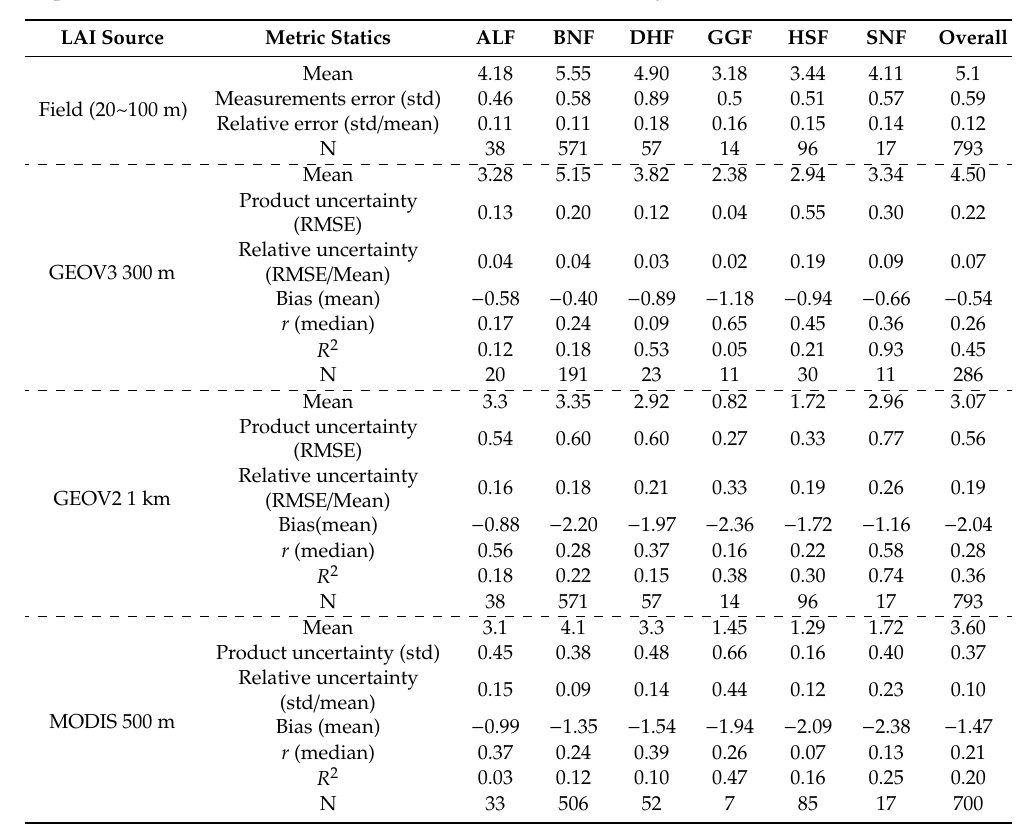
Table 2. Mean site LAI values (m 2 m − 2 ) and their statistical metrics calculated using months which have both field and EO LAI values from 2005 to 2017. “ r ” is median of the ratio between product uncertainty and bias for all months and subplots. R 2 was calculated from the linear regression between satellite products and field monthly measurements. “N” denotes the number of monthly values for all subplots at each site. All the statistics are calculated on a monthly